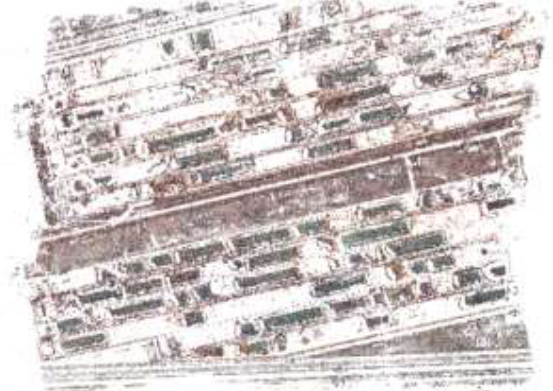
Fig. 8. Sparse scene geometry of the study area recovered with image topology matching strategy